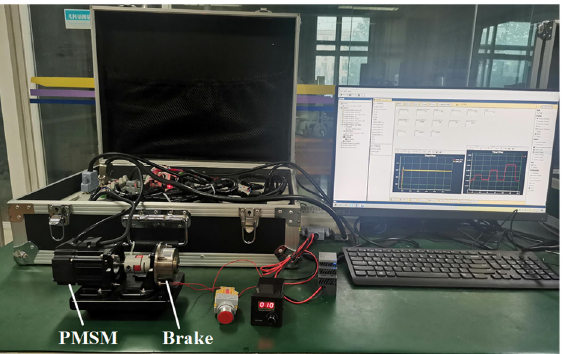
Figure 11. Permanent magnet synchronous motor (PMSM) servo control platform from Beijing Links Tech Co., Ltd. Tech Co.,